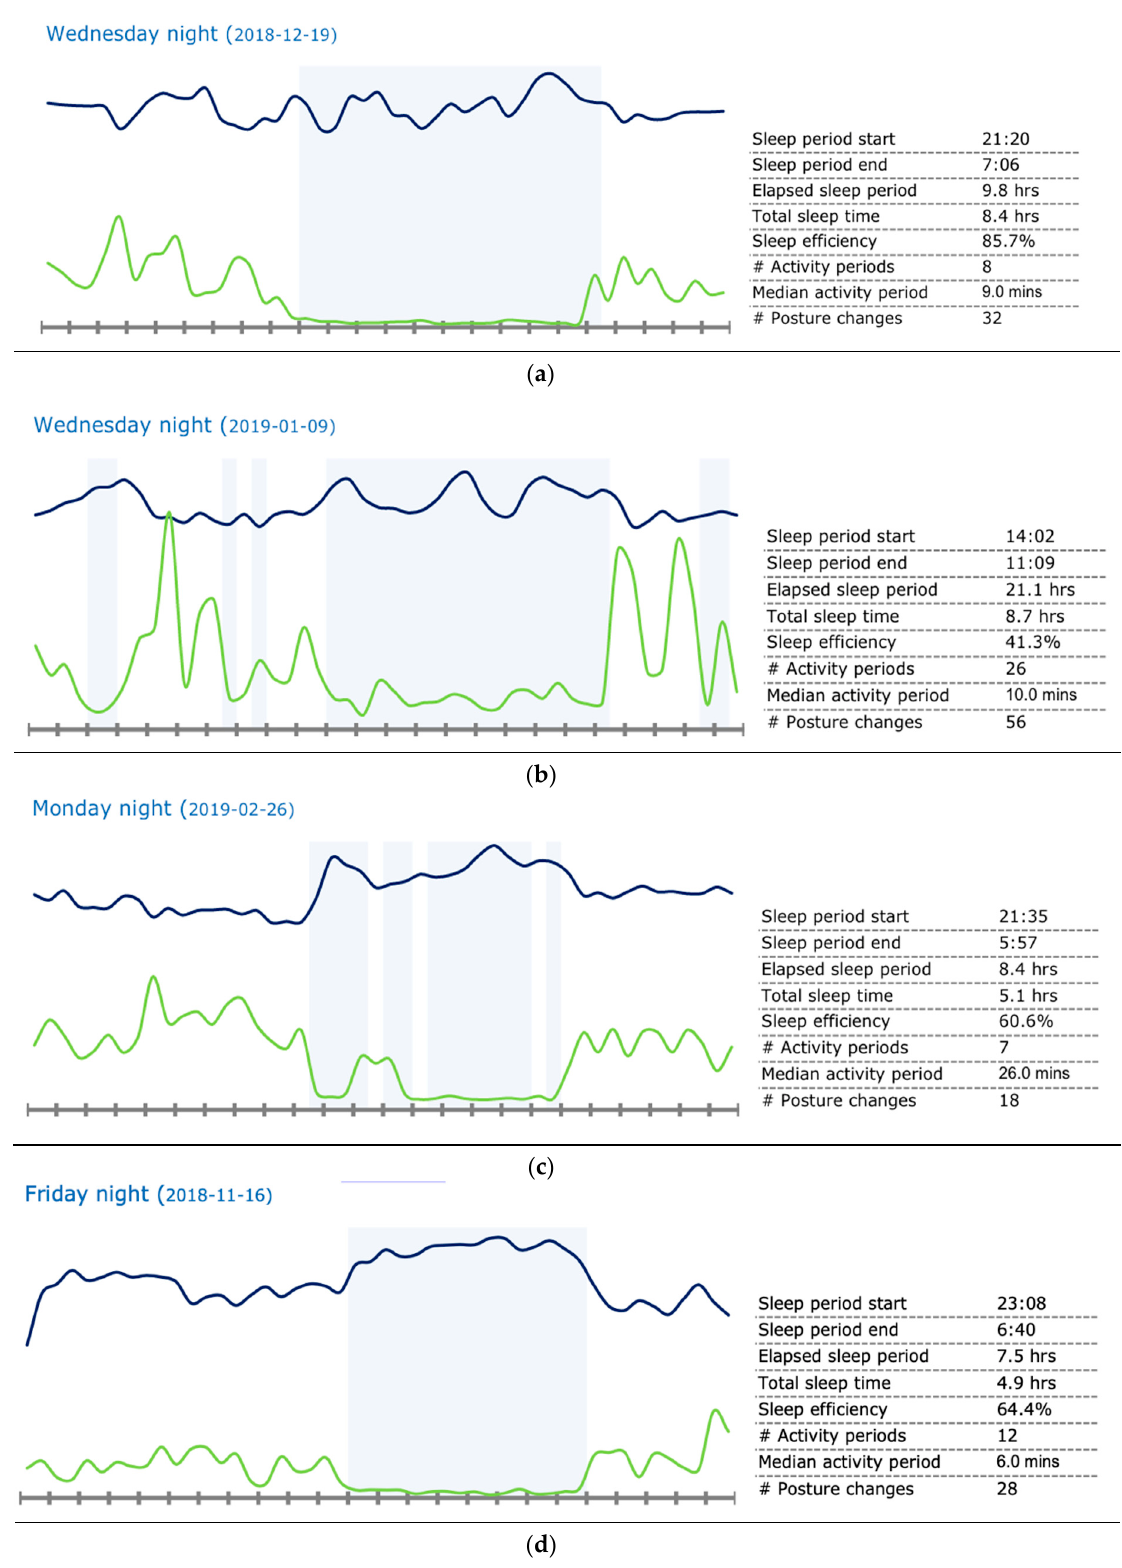
Figure 1. Case studies of sleep patterns. Note: GENEActiv graphs depicting various sleep patterns. The top line indicates temperature, the bottom line indicates activity, and the shaded area indicates sleep. This graph illustrates the period from noon to noon the next day. ( a ) Participant 103 (non-caregiver) showing a typical, ideal sleep pattern. ( b ) Participant 107 (caregiver) showing daytime rest. ( c ) Participant 114 (caregiver) showing sleep fragmentation (i.e., frequent night waking). ( d ) Participant 101 (caregiver) showing short sleep duration.